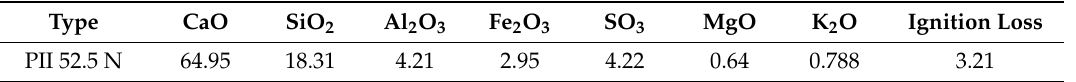
Table 1. Chemical compositions of Portland cement (wt